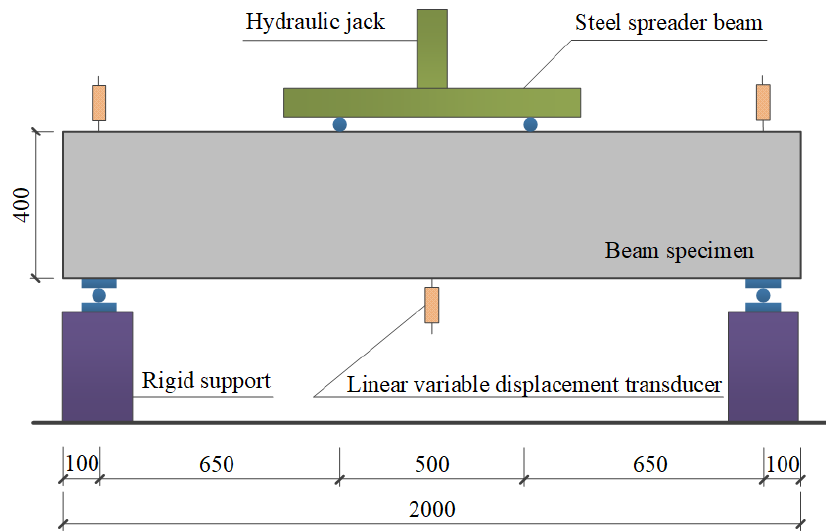
12 of 16 ( b ) Ultimate strengths Figure 11. Tensile strengths of corroded longitudinal steel bars: ( a ) average yielded strengths and ( b ) average ultimate strengths. 3.3. Flexural Performance of Degraded and Reinforced Concrete Beams The deterioration of concrete and steel bars affects the performance of beams. To check the flexural performance of degraded reinforced concrete beams, load-deflection curves are measured. To measure the flexural performance of degraded reinforced concrete beams, four-